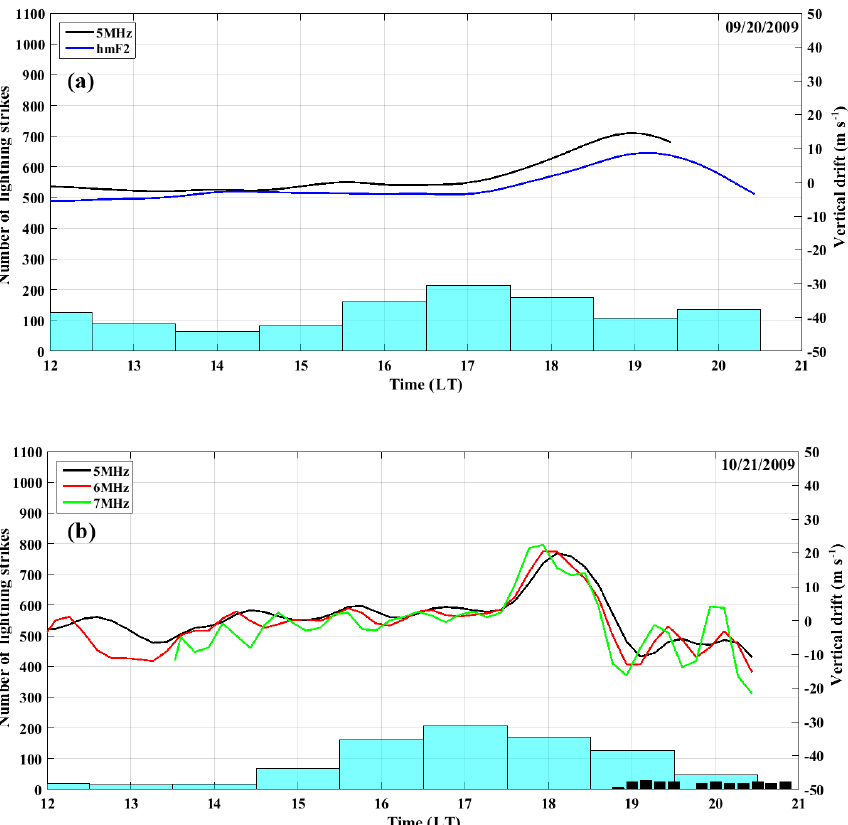
Figure 1. Vertical drift (colored curves), lightning strike activity (cyan bars) and range of spread F, i.e., Q f (black bars), for 20 Septem- ber 2009 (a) and 21 October 2009 (b) . In (a) , vertical drift was calculated through 5MHz frequency information (altitude) and hm F2 (peak height of the F2 layer). Other frequencies were not registered on this particular day. In (b) the calculation was performed using 5, 6 and 7MHz